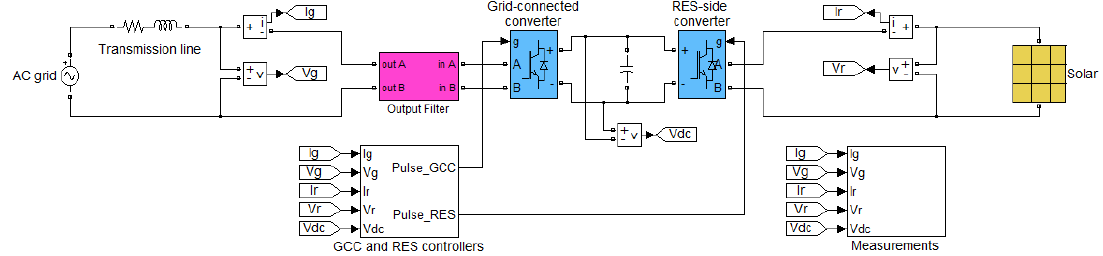
Figure 14. The AC/DC/DC converter experiment.